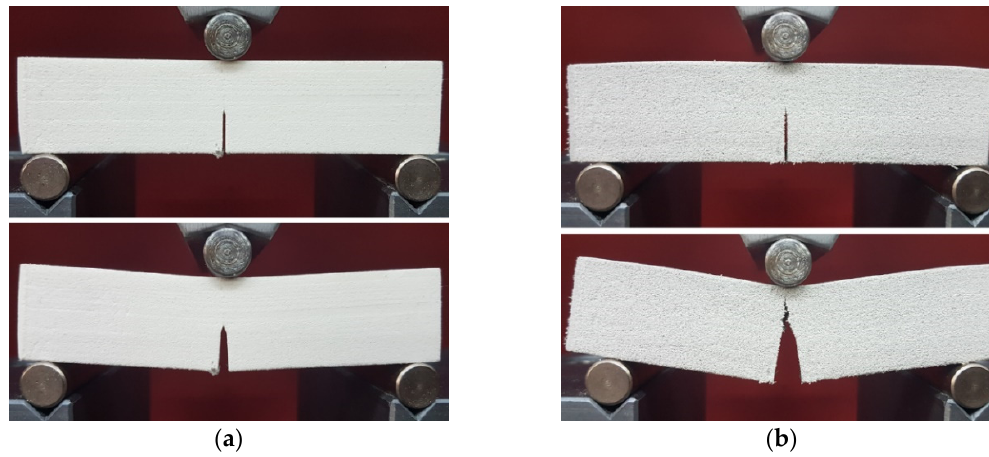
Figure 3. Polyamide ( a ) and Alumide ( b ) SENB samples before and after the quasi-static TPB test. The upper loading pin and bottom supports of TPB device were large enough in diameter (10 mm) in order to avoid sample indentation. The load-displacement data were automatically recorded using a sampling frequency of 600 Hz.